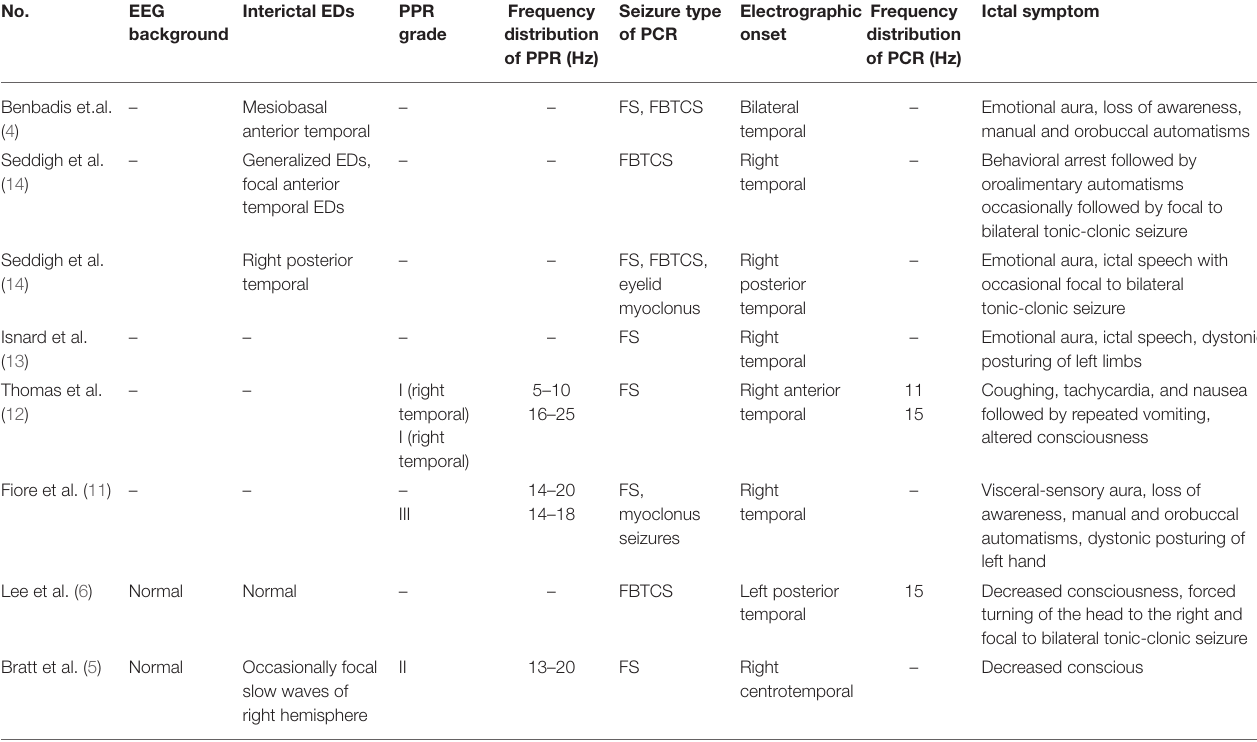
TABLE 3 | Summary of EEG findings of previously reported cases with temporal onset focal seizure induced by IPS.